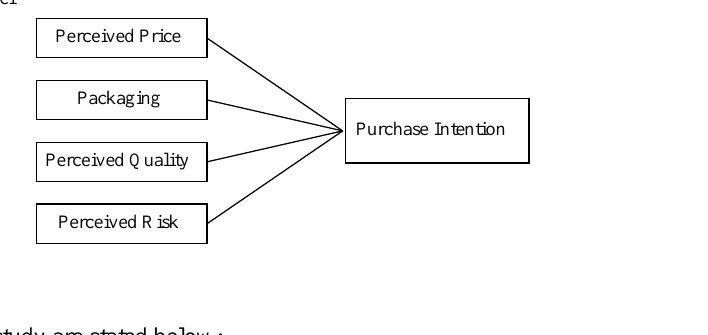
Figure 1. Conceptual Model